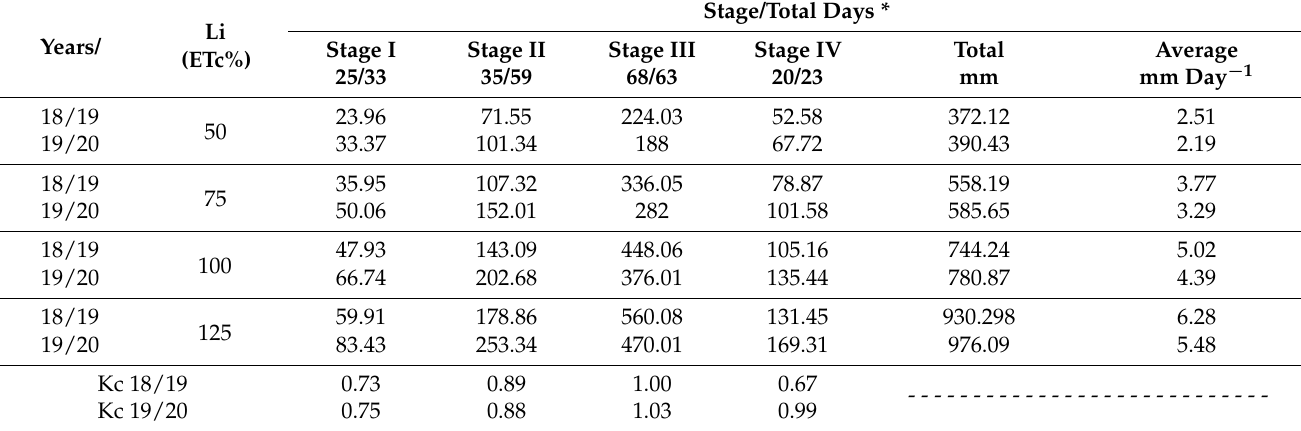
Table 2. Irrigation level applied—Li (mm) and crop coefficient—Kc in each growth stage and for